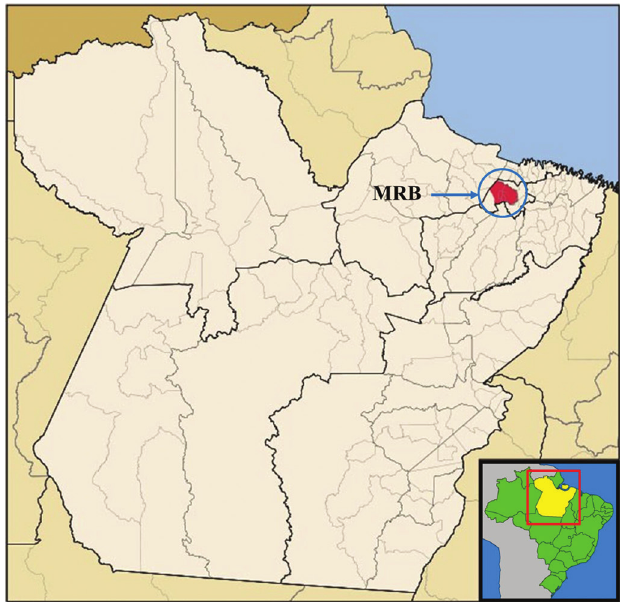
Figure 1 - Metropolitan Region of Belém (MRB) location within the state of Pará. At the bottom right the location of this state on the map of Brazil. Source: Adapted from Wikipédia